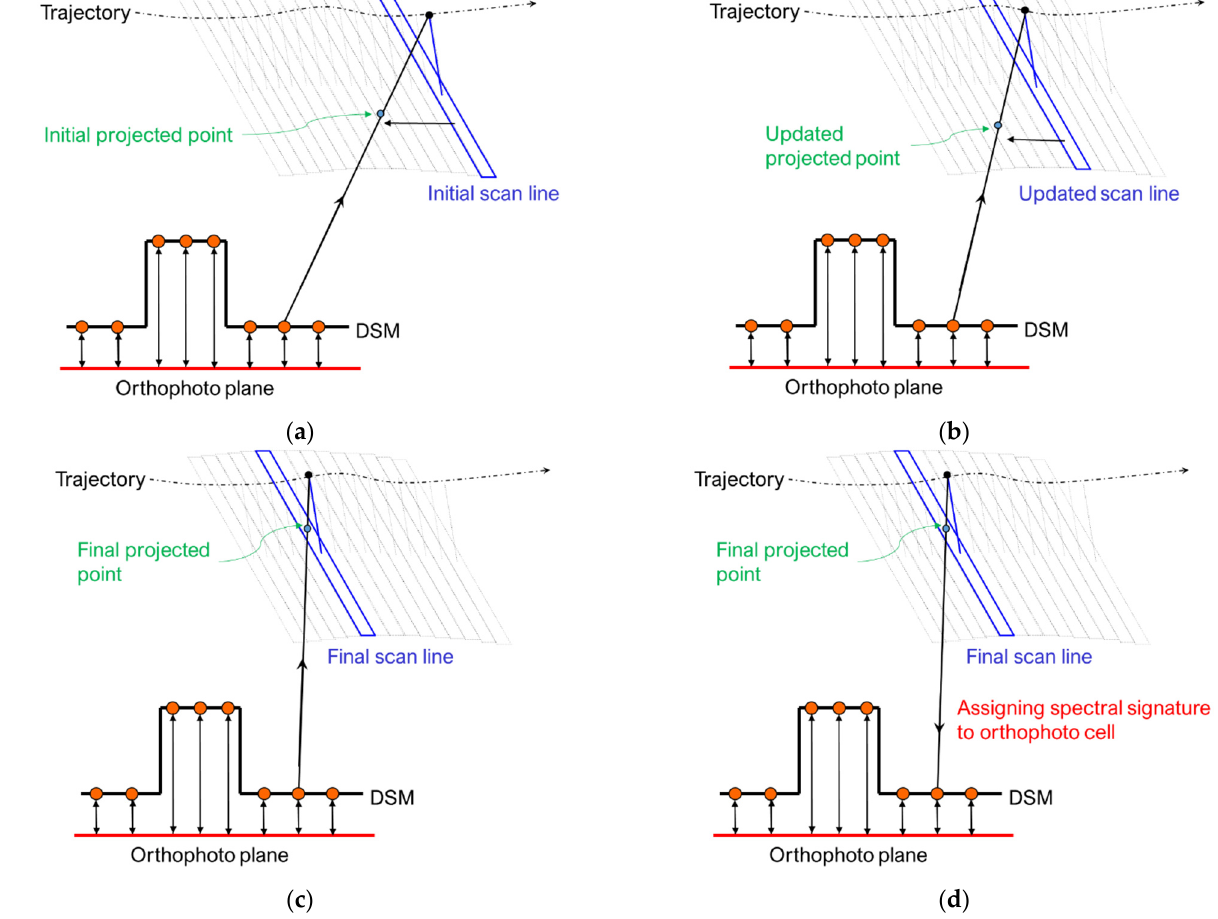
Figure 9. Schematic illustration of the iterative ortho-rectification process for push-broom scanner scenes: ( a ) projection of a given object point onto the initial scan line, ( b ) projection of the same object point onto an updated scan line derived from previous step, ( c ) final projection with x ≈ 0, and ( d ) assigning pixel spectral signature to the corresponding orthophoto cell.